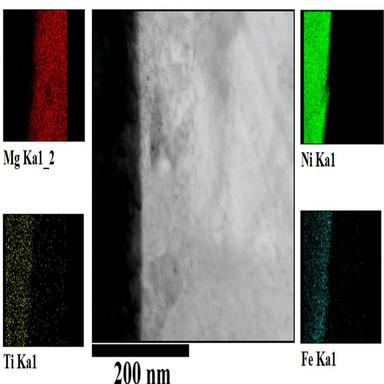
The high-magnification EDS elemental analysis maps from the Mg/Ni interface upon AFF consolidation, as determined by TEM analysis.